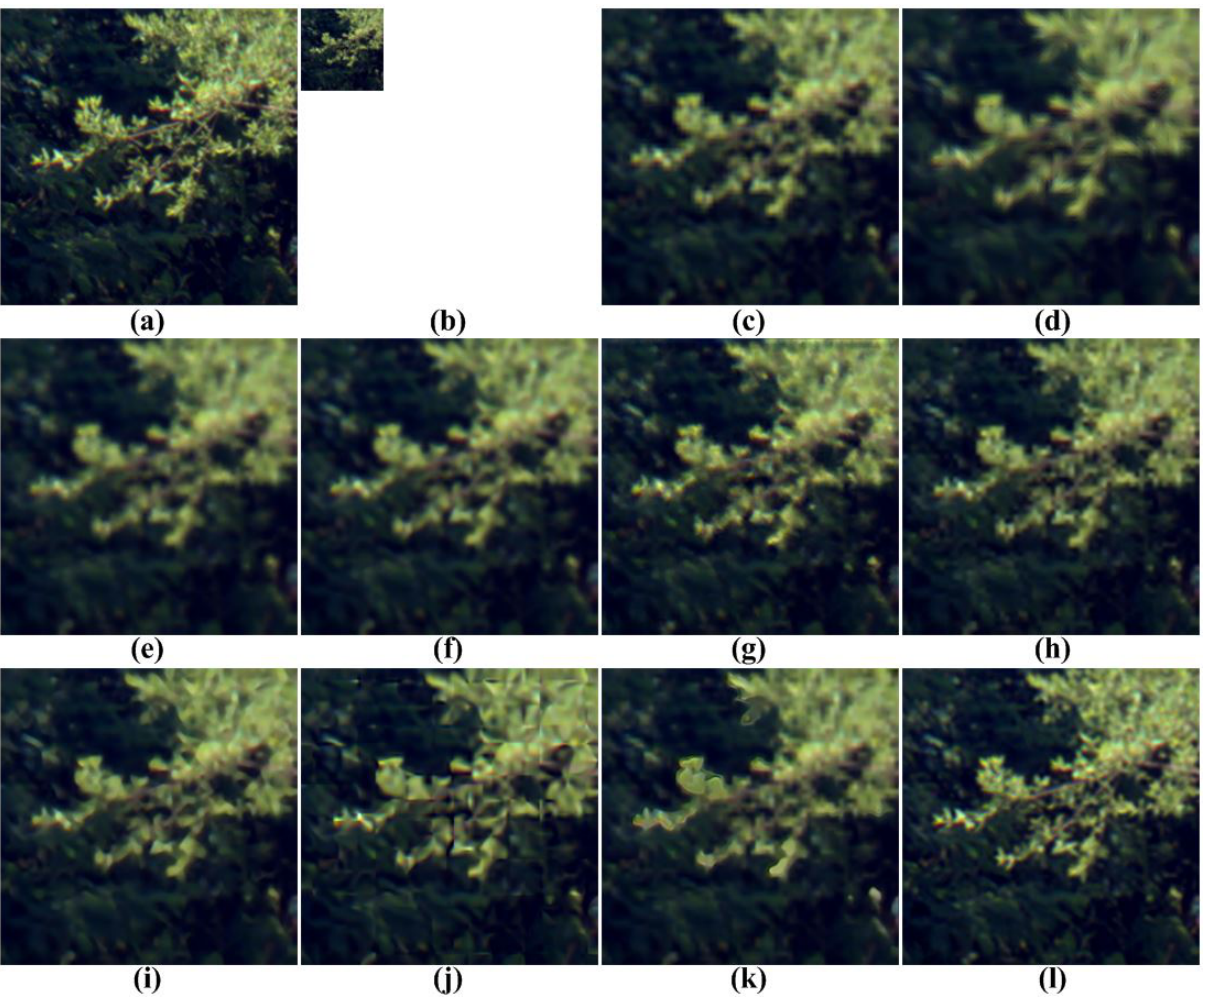
Figure 7. Results of resolution enhancement by enlarging a simulated LR multispectral image: ( a ) cropped original HR image in Figure 4c; ( b ) the four-times down-sampled LR image; results of: ( c ) cubic-spline interpolation [3], ( d ) interpolation-based SR [4], ( e ) interpolation-based SR [5], ( f ) interpolation-based SR [6], ( g ) example-based SR [7], ( h ) patch-based SR [9], ( i ) patch-based SR [10], ( j ) patch-based SR [11], ( k ) patch-based SR [12] and ( l ) the proposed